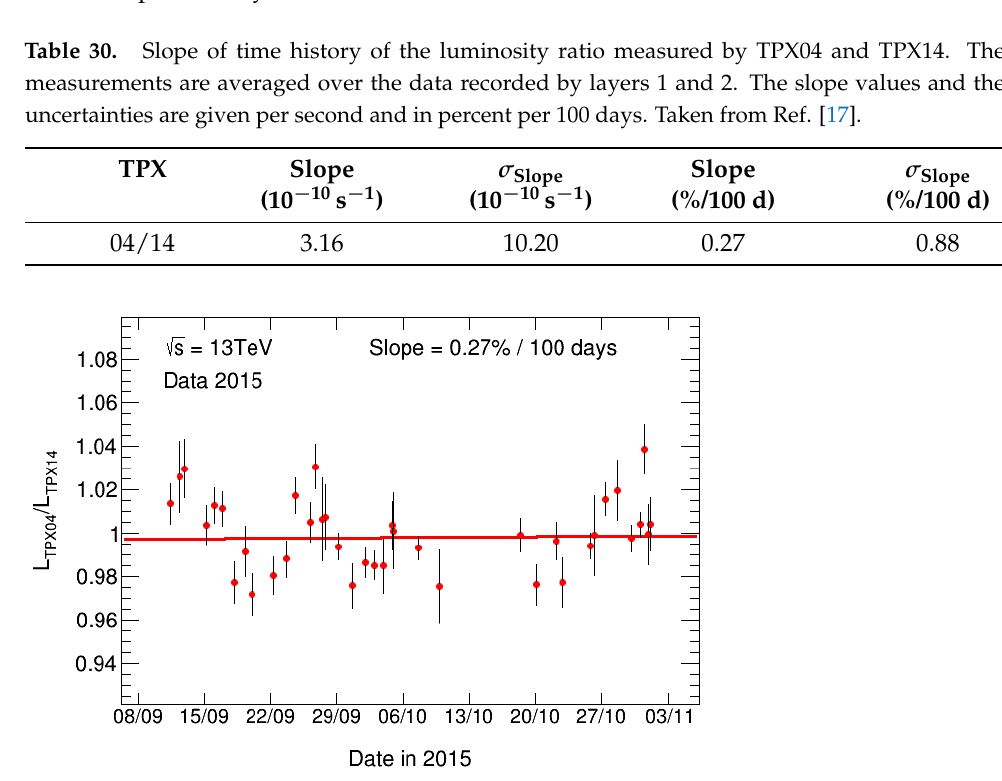
Figure 56. Time history of the luminosity ratio measured by TPX04 and TPX14. The measurements are averaged over the data recorded by layers 1 and 2. The 2015 TPX data are divided into luminosity blocks of typically one minute length and then grouped into LHC fill time periods. The statistical error bars are given. A linear fit is applied to determine the slope. The LHC fills from September to November 2015 are shown. Taken from Ref.